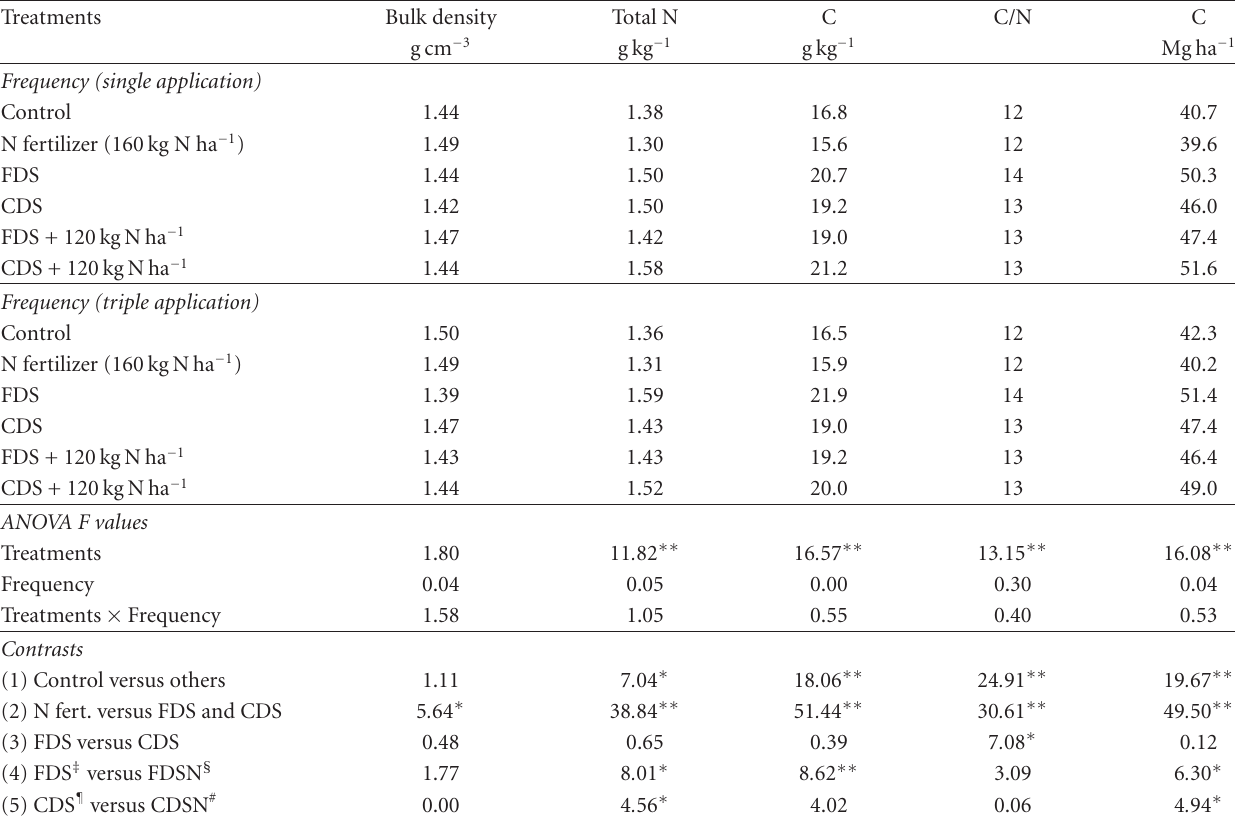
Table 3: Residual e ff ects of applications of fresh and composted paper sludges, and N fertilizer on soil bulk density, nitrogen and